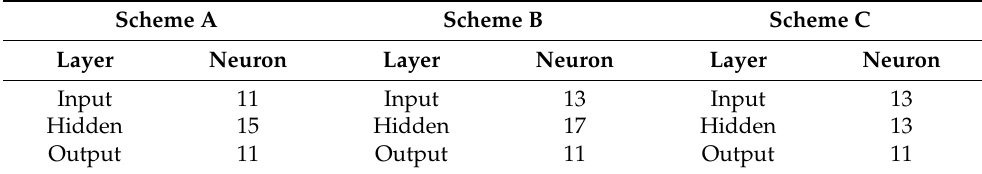
Table 9. Number of neurons.